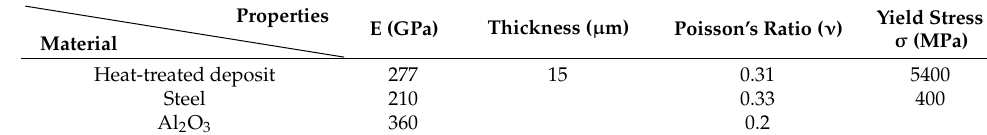
Table 5. Data needed to calculate P max using Hertz equations.